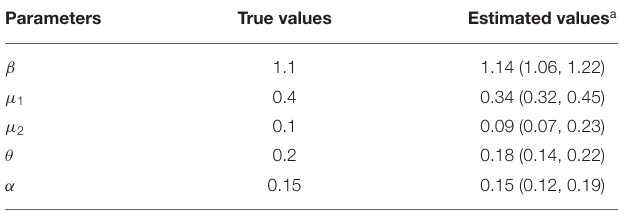
TABLE 3 | Results of synthetic testing.